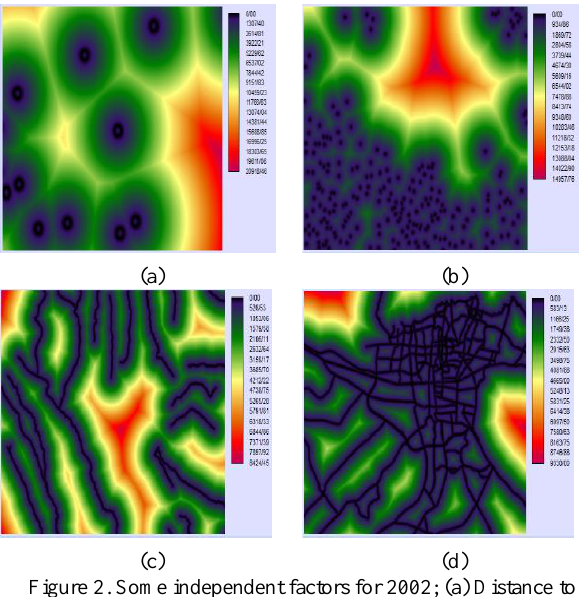
Figure 2. Some independent factors for 2002; (a) Distance to nearby cities, (b) Village, (c) rivers, (d) roads